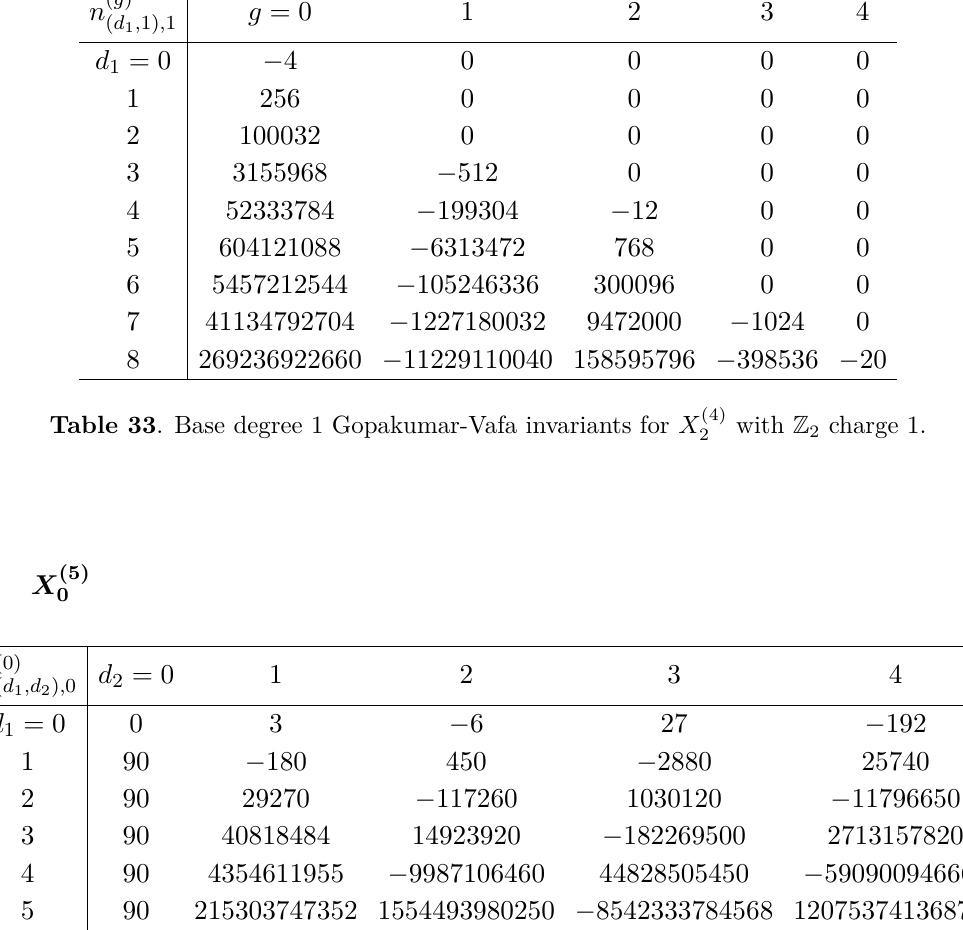
Table 34 . Genus 0 Gopakumar-Vafa invariants for X (5)